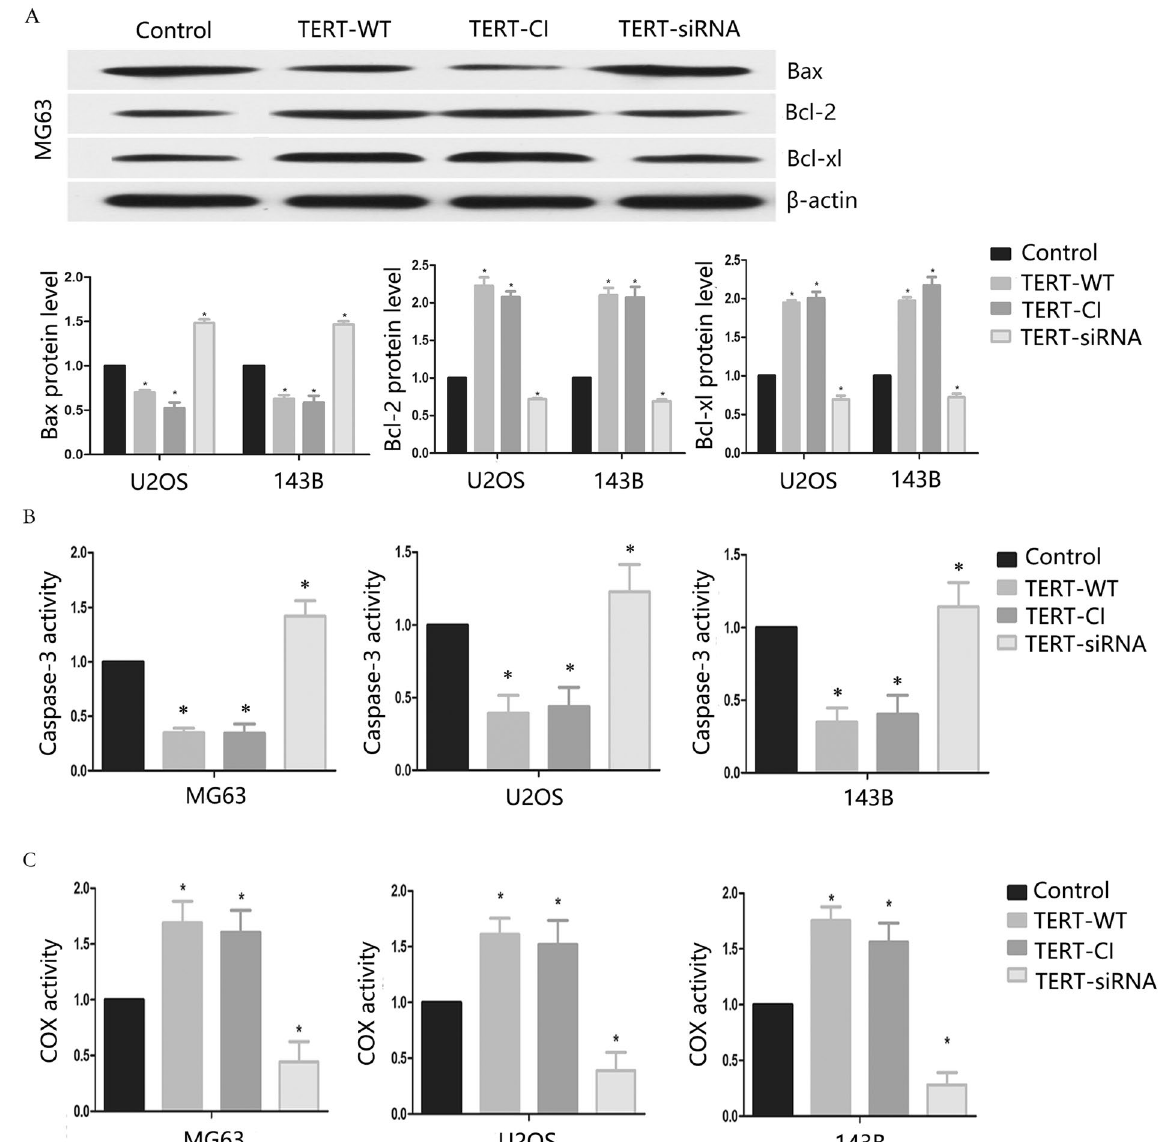
Figure 3. TERT inhibits mitochondrial apoptotic pathway in cisplatin-treated osteosarcoma cells. ( A ) proapoptotic Bax expression and antiapoptotic Bcl-2, Bcl-xl expression in transfected osteosarcoma cells were assessed by Western blot analysis. ( B ) Caspase-3 activity in transfected osteosarcoma cells was assayed using a caspase assay kit, following the manufacture’s protocol. ( C ) Transfected osteosarcoma cells were subjected to COX activity assay, spectrophotometrically determining the rate of COX activity through the addition of reduced cytochrome c. All experiments were carried out at least triplicates and the data were presented as the mean ± S.D. Student t test was performed to evaluate the difference * P <